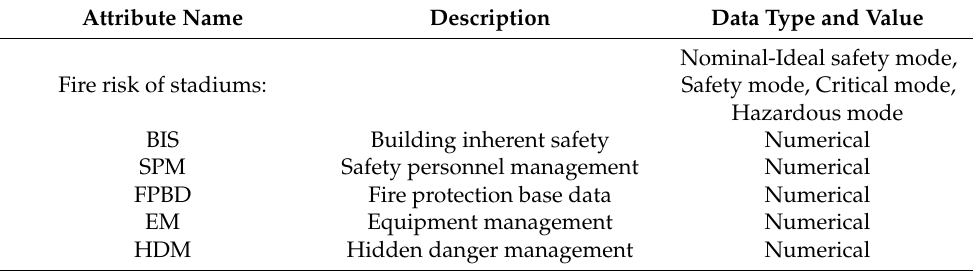
Table A1. Description of attributes from Stadium Fire Risk Dataset.